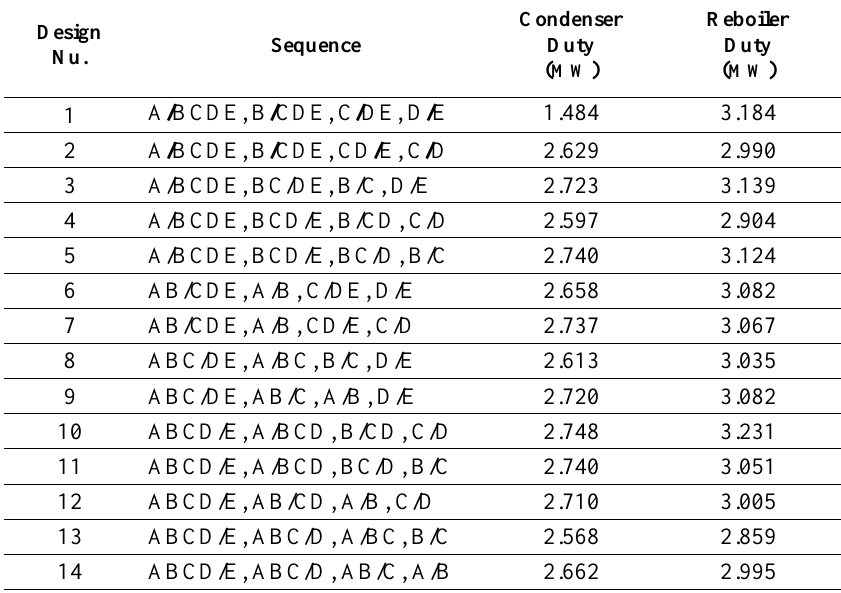
Table 7. Energy consumption at hot and cold utilities used to column